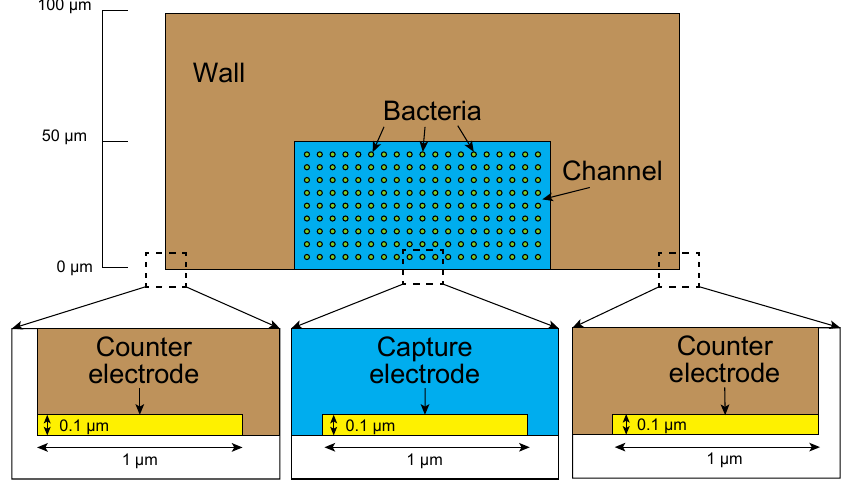
Figure 2. Analysis space in the numerical analysis. Table 1. Physical properties for numerical analysis.